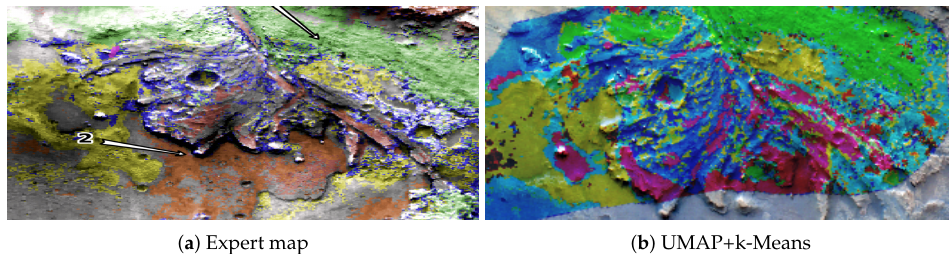
Figure 4. On the left side, the expert map used by Gao et al. [11] is presented. Each class is associated with a different color. In total, 6 classes are clustered as follows: olivine, yellow; pyroxene, orange; carbonate, green; Fe/Mg smectite, blue; silica, magenta and unclassified area, gray. On the right side, the UMAP+k-Means generated spectral cluster map with 6 identified clusters is illustrated. The same detail, as captured by expert map ( a ), is shown.